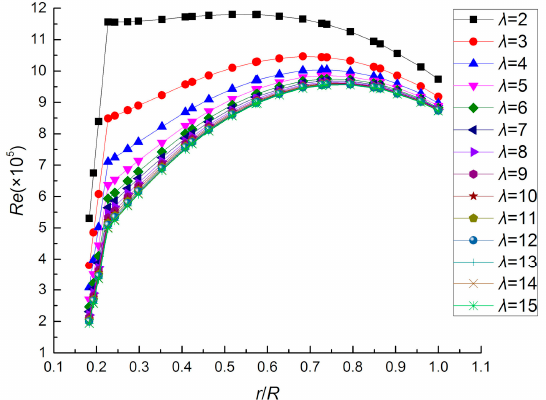
Figure 2. Re number distributions of Phase VI blade sections at different tip speed ratios and rated rotational speed of 72 rpm.